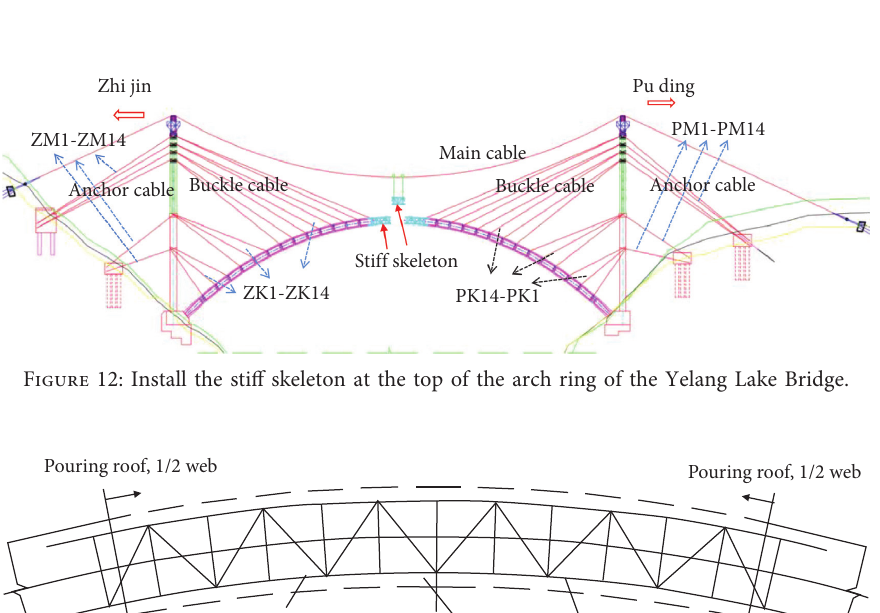
Figure 11: The concrete of segment i +1 of the arch ring after pouring.